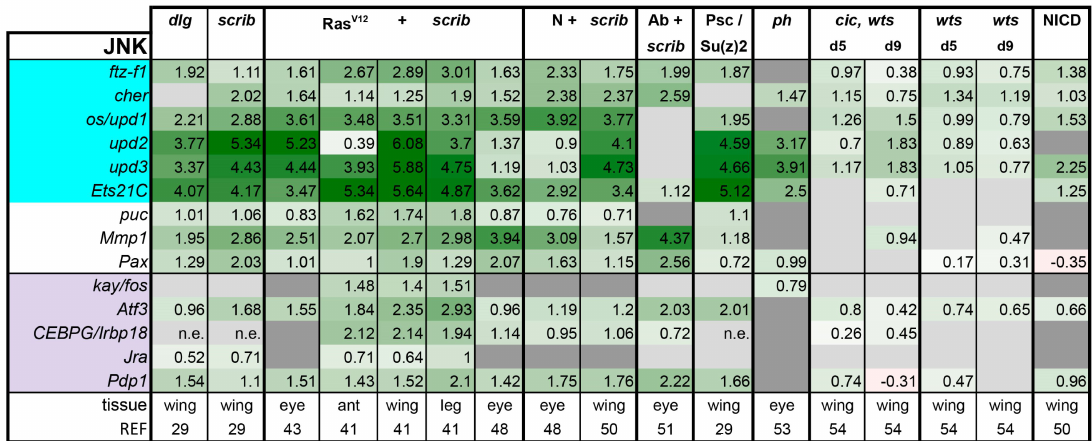
Figure 5. Activation of JNK is a common feature of all tumor models analyzed. Light purple highlights nuclear factors of the JNK pathway. Target genes that are known to also be regulated by other pathways are highlighted in cyan. Gene expression is displayed in log2FC. Color coding corresponds to a heatmap with a scale from − 5 (dark red) to 5 (dark green). Light grey cells represent non-significant changes with p ≥ 0.05. Dark grey: the gene was not found in the dataset. n .e. = not expressed, the gene was in the data, but showed 0 reads. Abbreviations: ftz transcription factor 1, ftz-f1 ; cheerio, cher ; outstretched, os ; Ets at 21C, Ets21c ; Paxillin, Pax; kayak, kay; Activating transcription factor 3, Atf3; CCAATT Enhancer Binding Protein Gamma, CEBPG; Inverted repeat binding protein 18, Irbp18; Jun-related antigen, Jra; PAR-domain protein 1,